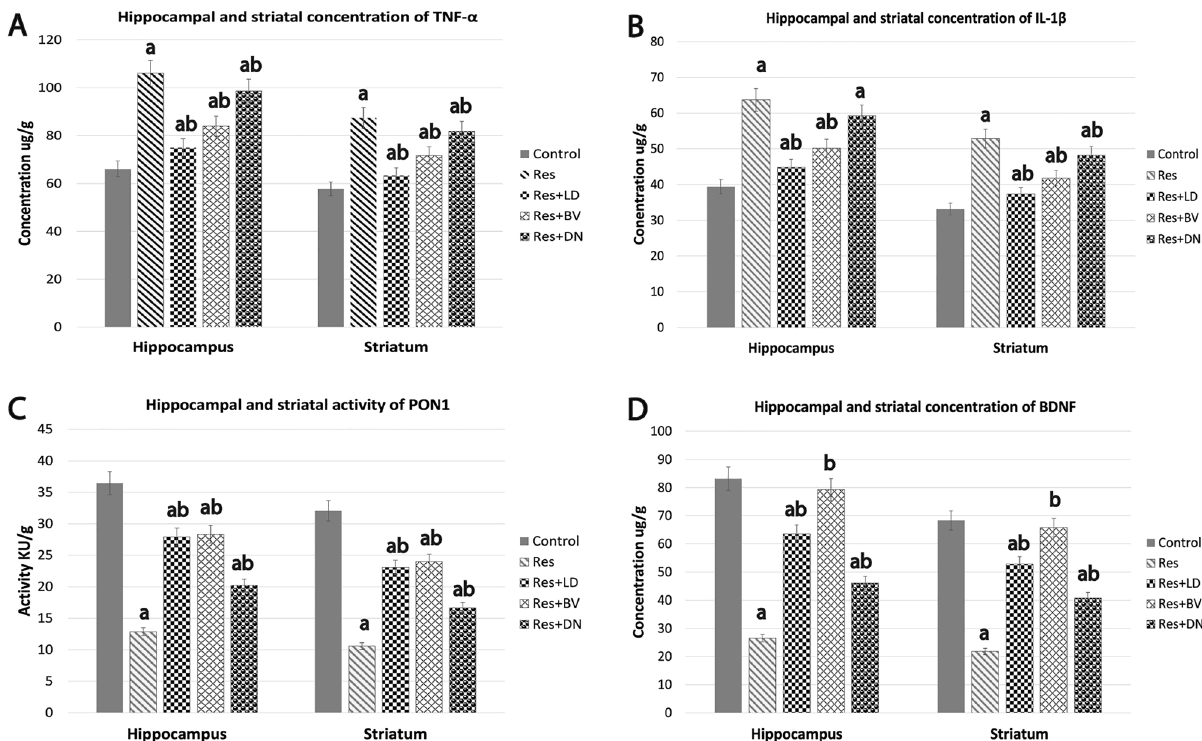
Figure 3. HPLC analysis of the effects of L-Dopa, BV, and DA nanoparticles on hippocampus and striatal inflammatory mediators in a reserpine-induced Parkinson’s rat model. ( A ) Tumour necrosis factor alpha (TNF-α), ( B ) Interleukin 1 β (IL-1β), ( C) Paraoxonase-1 (PON1), and ( D ) Brain-derived neurotrophic factor (BDNF). Data are expressed as Mean ± S.E. for 6-rats/group. a indicates significant difference from control group ( p < 0.05), b indicates significant difference from the reserpine-treated group ( p < 0.05), ab indicates significant difference from both control and reserpine-treated